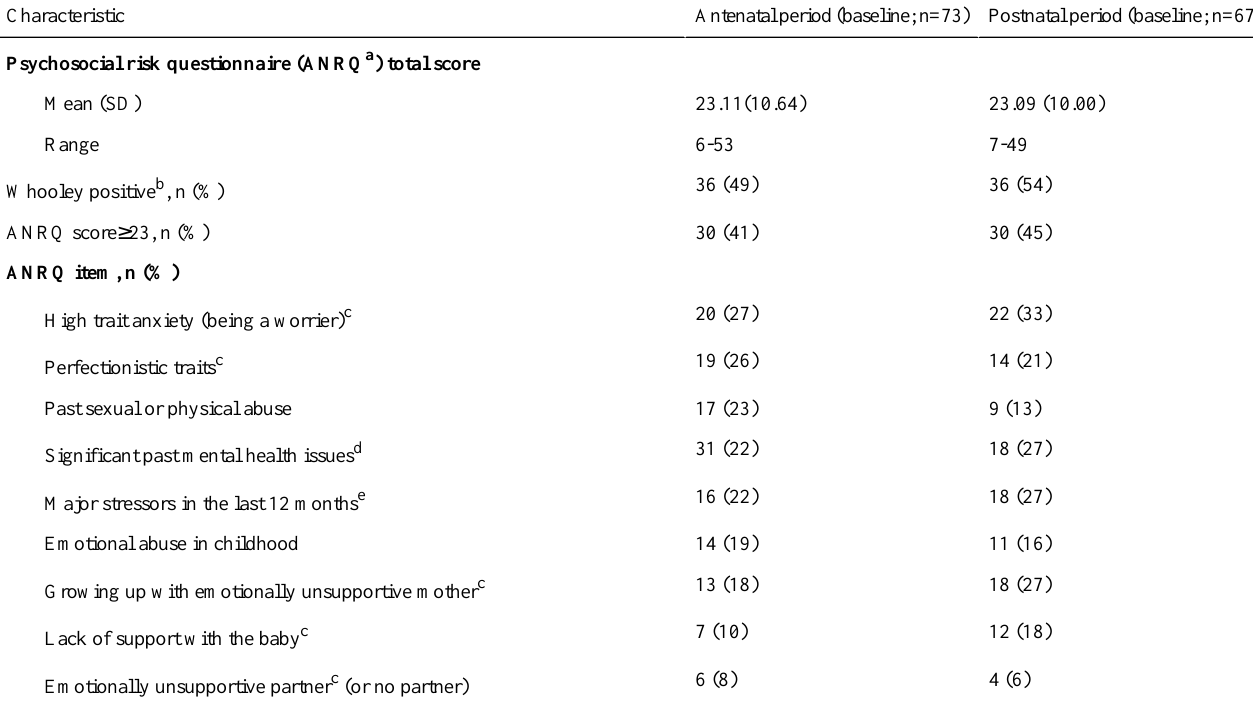
Table 2. Psychosocial profile of mummatters evaluation